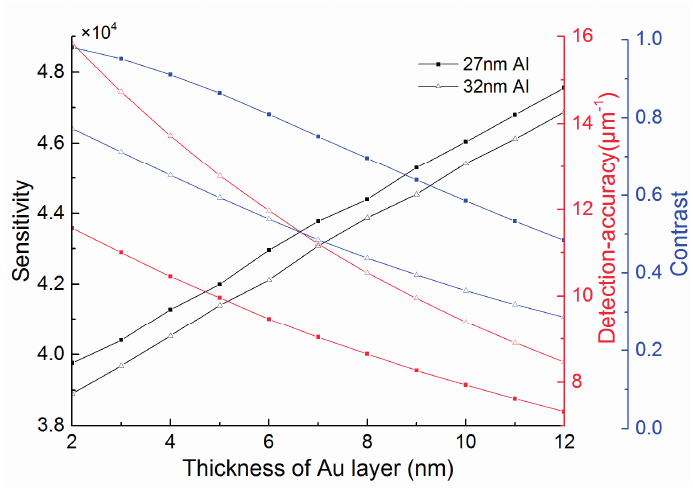
Figure 10. The influence of the thickness of Au layer in the bimetallic SPR sensor with 27 nm or 32 nm